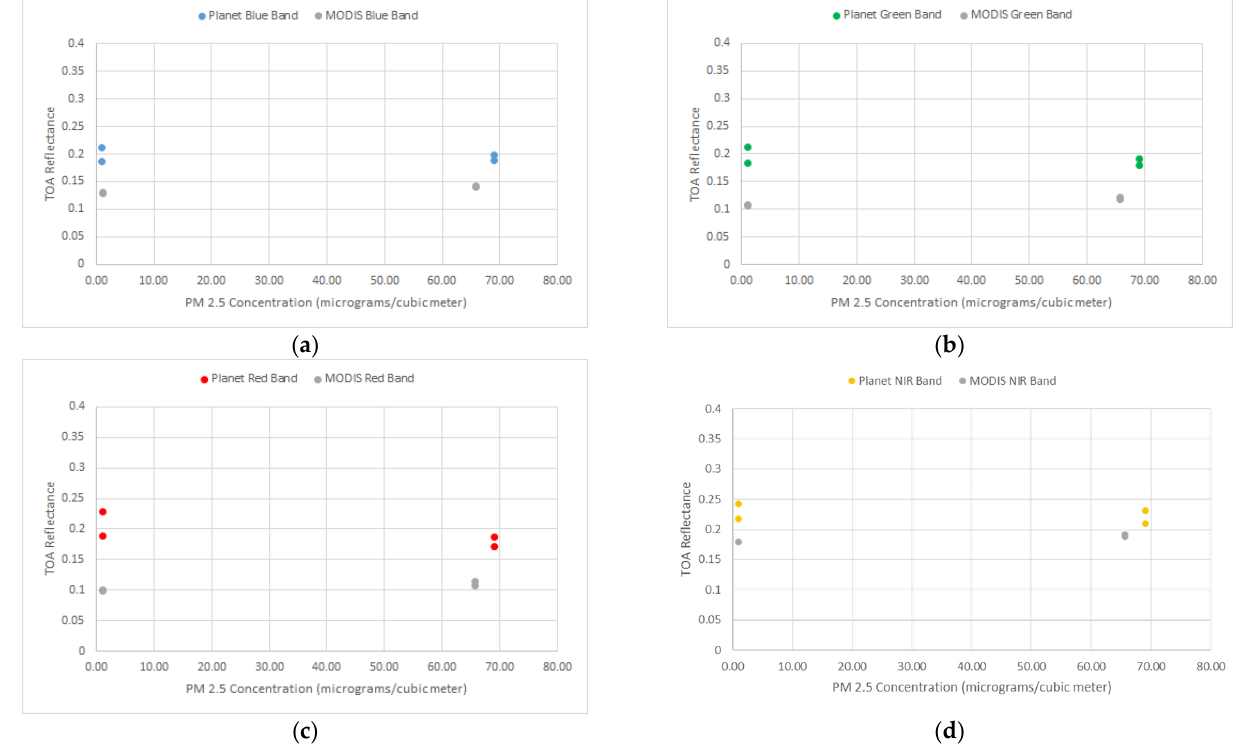
Figure 6. Data points from Figure 5 isolated for the SPOKANE—AUGUSTA AVE station for ( a ) the blue band; ( b ) green band; ( c ) red band; ( d ) and NIR band. Low PM 2.5 values are from 4/19/2018 and high PM 2.5 values are from 8/14/2018.